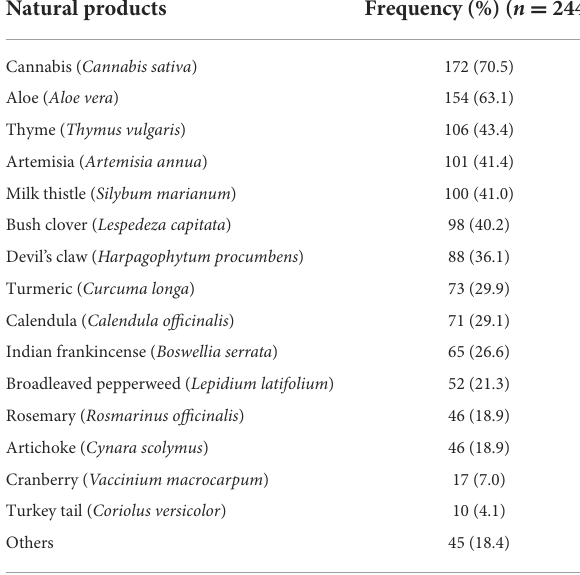
TABLE 4 Other natural products employed in disease treatment of the pets by Spanish small animal veterinarians. Natural